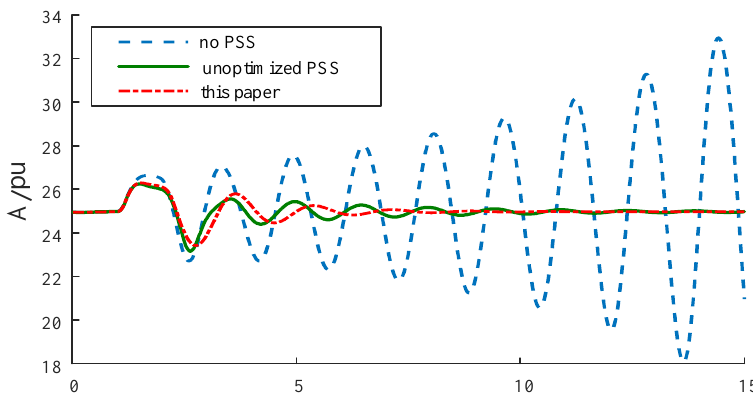
Figure 12. Speed change.